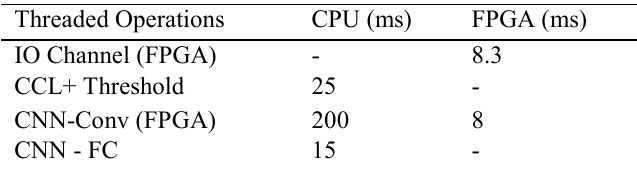
Table 3. Resource Utilization on Cyclone V